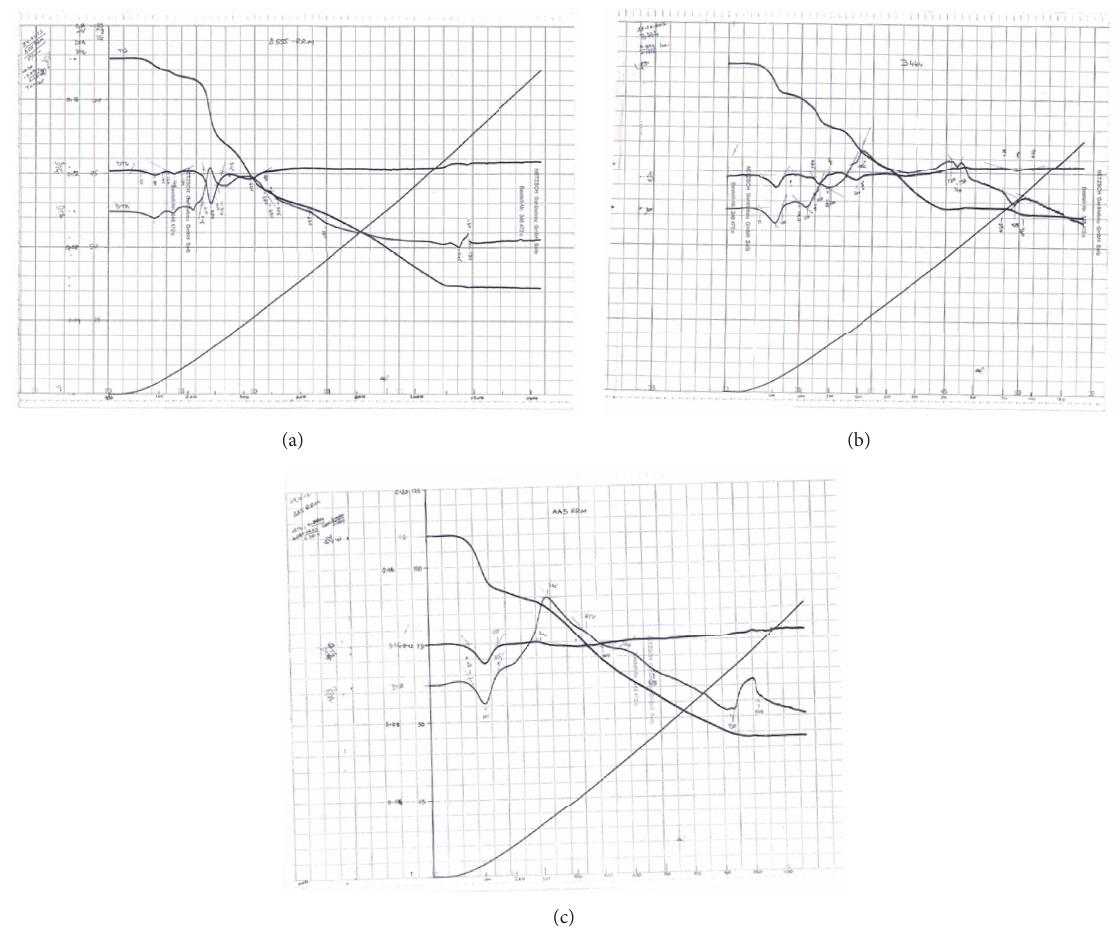
Figure 8: (a) TG/DTA graph of [Ni 2 L 󸀠 Cl 2 (H 2 O) 6 ] complex. (b) TG/DTA graph of [Co 2 L 󸀠 Cl 2 (H 2 O) 6 ] complex. (c) TG/DTA graph of [Ni 2 LCl 2 (H 2 O) 6 ]